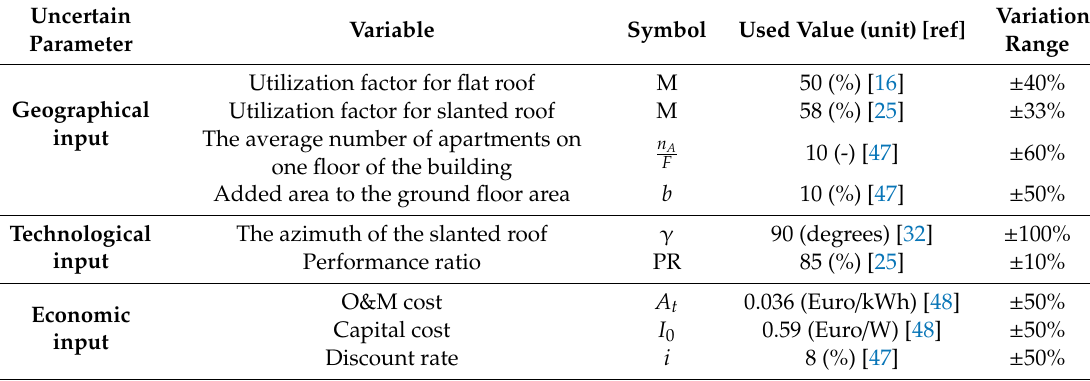
Table 4. Employed values of the uncertain parameters and their considered variation range in this study.